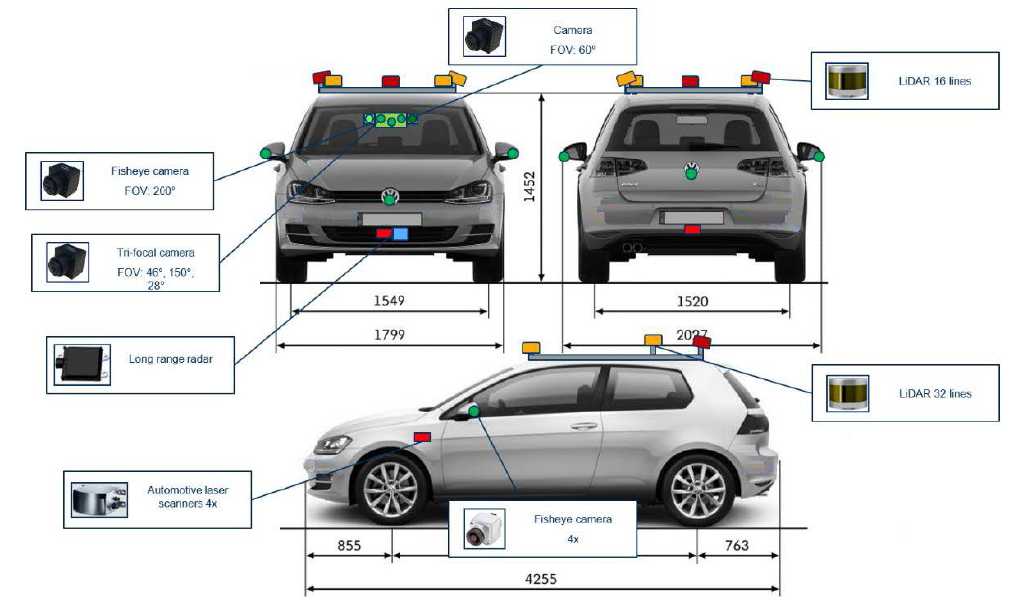
Figure 1. Position of sensors on the ego vehicle.